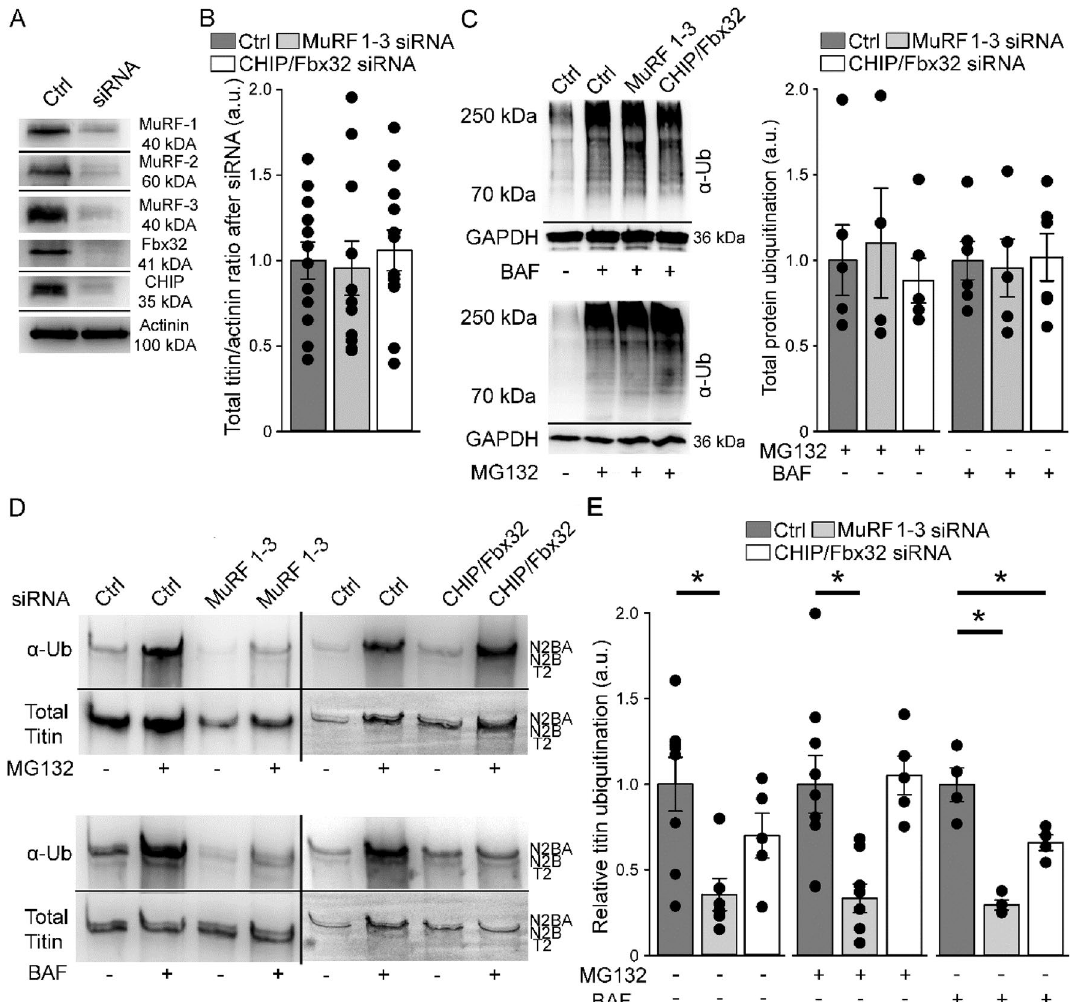
Figure 3. Decreased titin ubiquitination by the knock-down of E3-ligases. Cardiomyocytes were treated with siRNAs and 72 h later with BAF or MG132 for 24 h. ( A ) Representative Western blot images of E3-ligase knock- down. ( B ) Titin/Actinin ratio in siRNA treated cells under basal conditions (n = 11–12). ( C ) Representative Western blot images and analysis of protein ubiquitination in the range of 70–250 kDa in siRNA treated cells after autophagy or proteasomal inhibition (n = 4–6) and. ( D ) Representative Western blot images of siRNA treated cardiomyocytes with or without inhibition. (E) Analysis of titin ubiquitination levels after MuRF-1, -2 and -3 or CHIP/Fbx32 siRNA treatment (n = 5–8). Either Coomassie stained membranes or an antibody targeting titin PEVK was used in titin blot as a marker for titin loading. Data are shown as mean ± SEM. Asterisks ( P < 0.05 in one-way ANOVA with Bonferroni t -test) mark statistical significance. BAF = bafilomycin; Ctrl = control; MG132 = proteasome inhibitor; α-Ub = anti-Ubiquitin